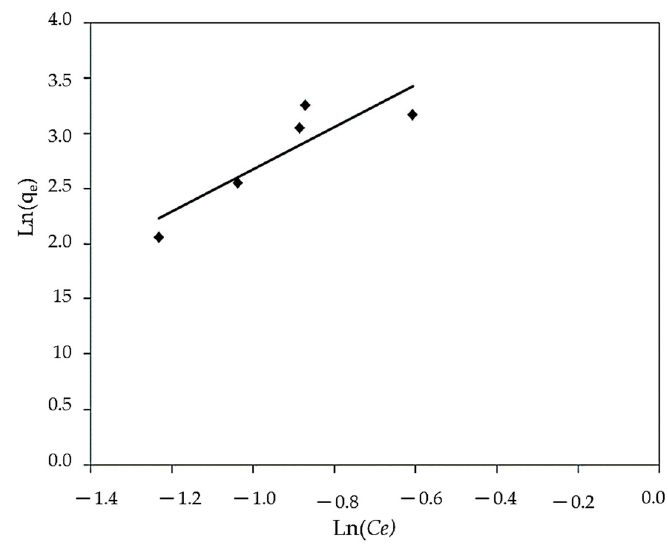
Figure 14. Linear Halsey isotherm for MBD sorption.